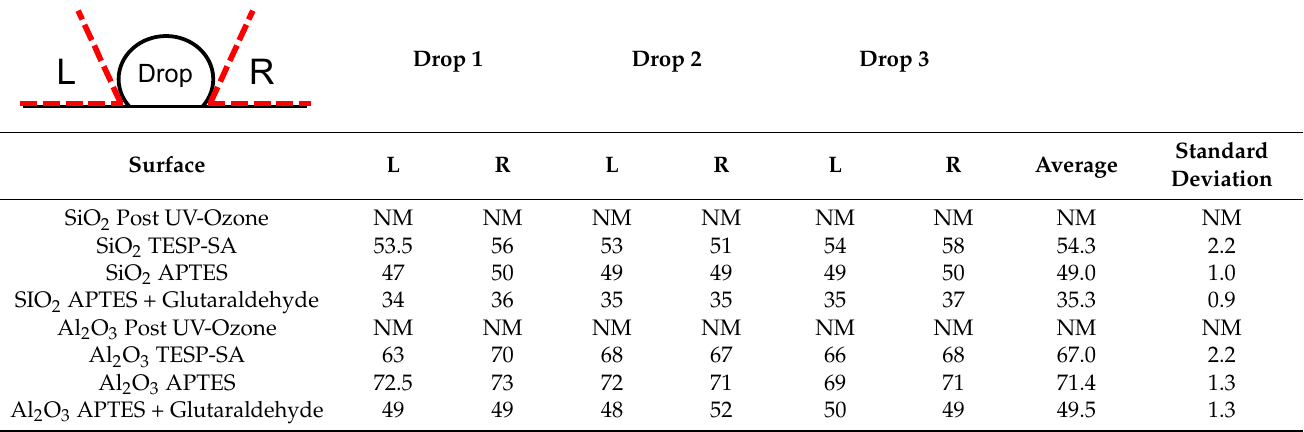
Table 1. Contact angles measured for Si/SiO 2 and Al/Al 2 O 3 surfaces before and after reaction with TESP-SA silane or APTES silane followed by glutaraldehyde. All values are in degrees. “NM” = not measurable.